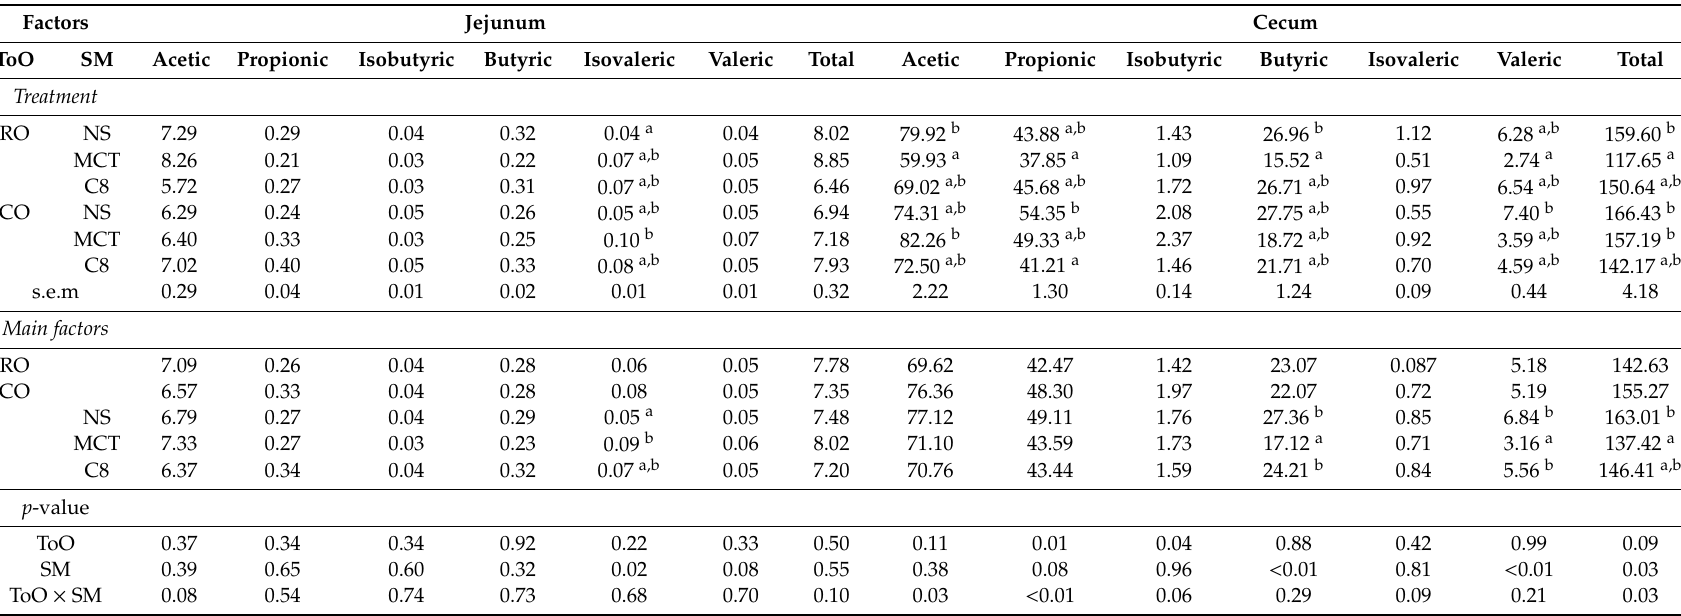
Table 7. Various parts of intestines and volatile fatty acid (VFA) content of piglets’ chime ( µ mol / g chyme) at 60th day of